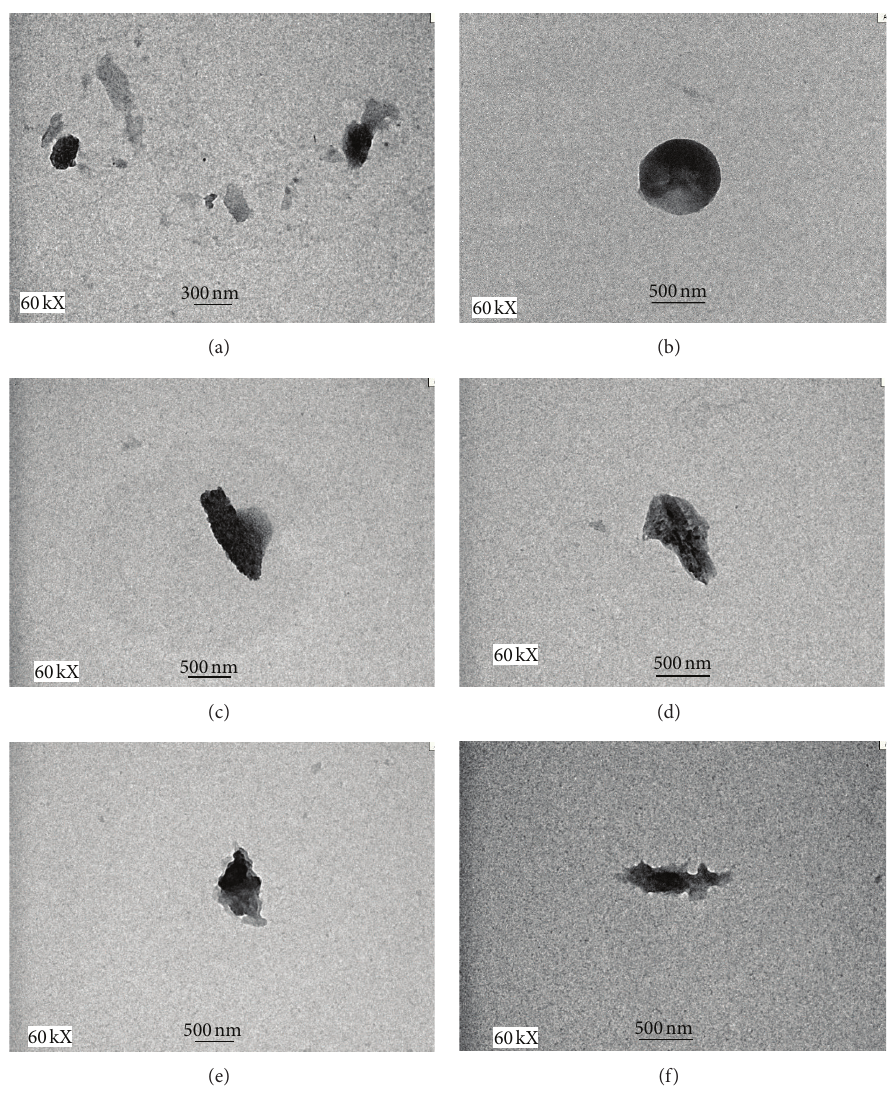
Figure 2: TEM images of CS NPs. (a) and (b) Unloaded CS NPs at 0.5: 1 and 1:1, (c) and (d) BSA loaded CS NPs at 0.5: 1 and 1:1, and (e) and (f) siRNA loaded CS NPs at 0.5 :1 and 1:1, respectively. All the images were taken at 60kX